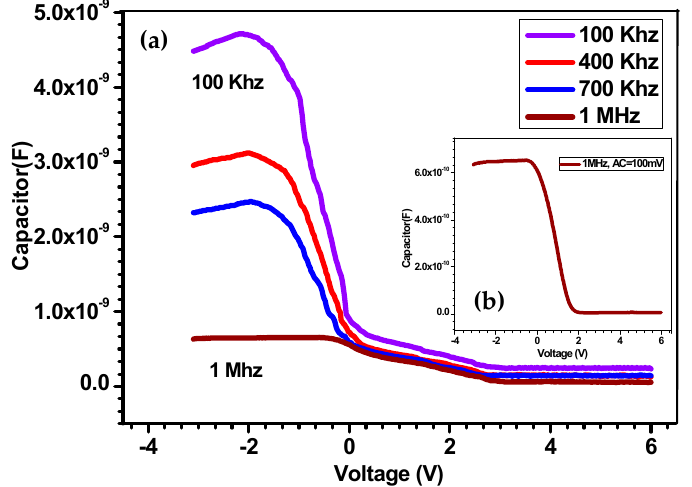
Figure 6. ( a ) Plot C – V measurement for the as-deposited Al/SiO 2 / p- GaN MOS Schottky diode measurement at different frequencies between 100 kHz and 1 MHz, AC = 100 mV. ( b ) The electrical properties of the diode was measured at frequency of 1 MHz, AC = 100 mV.